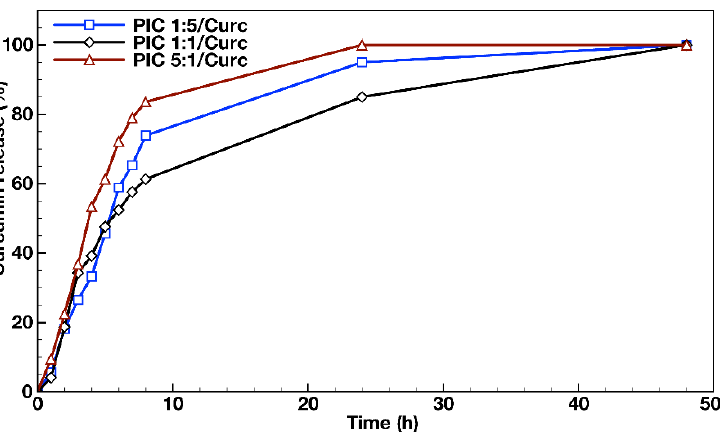
Figure 5. In vitro release profiles of curcumin from the PIC micelles prepared at different molar ratios between the oppositely charged groups of the hybrid block copolymers in distilled water containing 1% ( v / v ) Tween ® 20 at 37 °C.